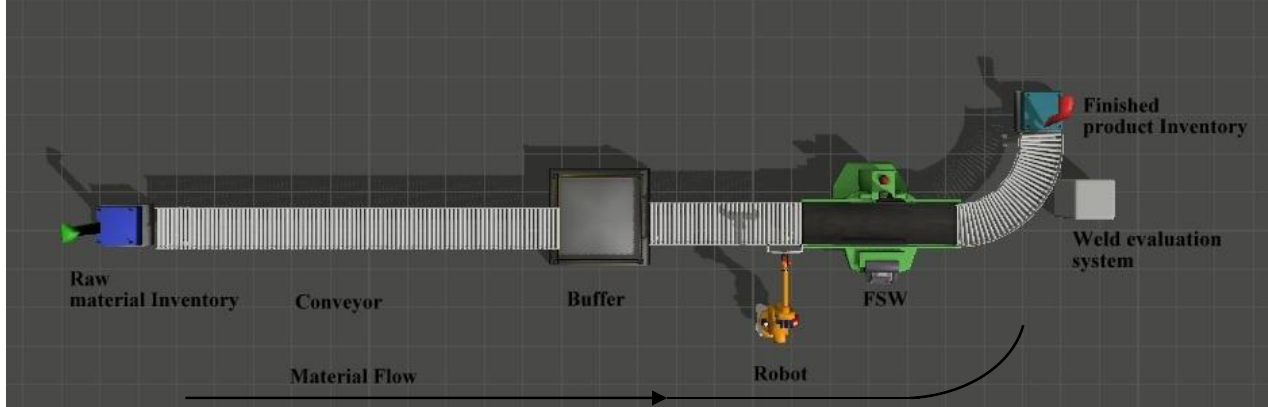
Fig. 3 Automated FSW cell